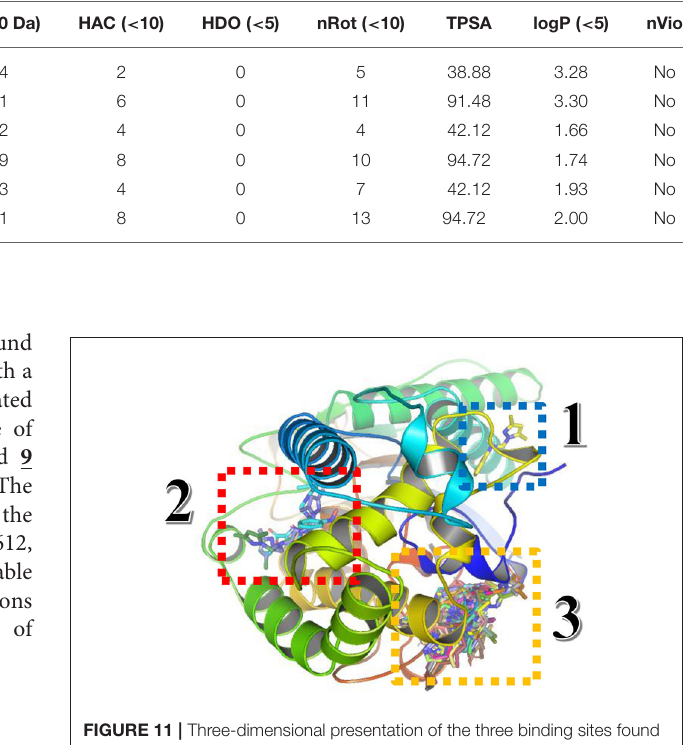
LYS95, PHE253, ALA259, ASP260, HIS322, ILE326, ASP329, TYR330, SER333, HIS340, ASN398, ALA421, GLU422, ASN423, ILE424, THR425, THR427, PHE430, SER431, and TRP434, where 15.09% of the bonds are with ILE424, 14.62% with ASP329, 10.37% with TRP434, 9.43% with LEU82, and 7.5% with